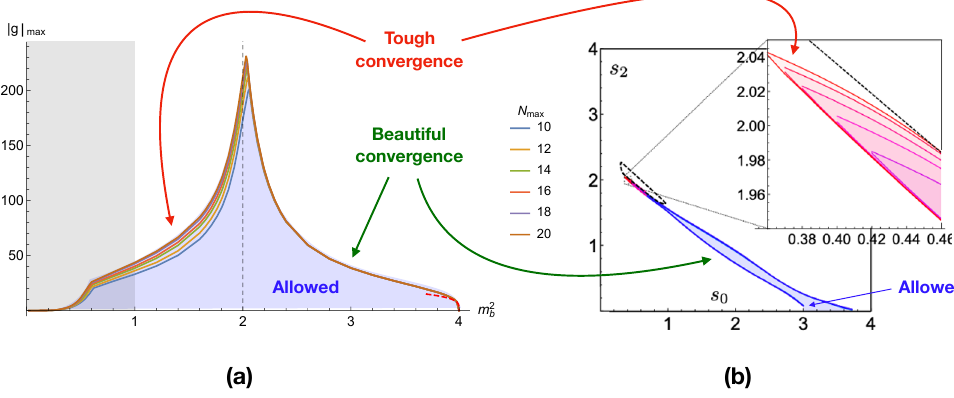
Figure 4: Largest possible value g as a function of m 2 b , using a triple rho expansion of the | | max amplitude for the given values of N max and after imposing the unitarity constraints for spins up to ` max = 20. As explained in the text, the shaded area is physically incompatible with our analyticity assumption. We added the analytic result of appendix E as the dashed line near m 2 b = 4. Figure 1 . a ) Maximal cubic coupling showing up in the scattering of the lightest particle in a gapped theory with a single bound-state (in this channel at least) [1]. Convergence is perfect ` ` max and along a grid of values for s . Experimentally we observe that our results remain  when the bound-state mass (measured in units of the lightest mass) is bigger than meaningful if ` max is not much smaller than N max and if the grid is su  ciently refined. In appendix F we discuss the dependence on these parameters in more detail, and outline the numerical implementation.